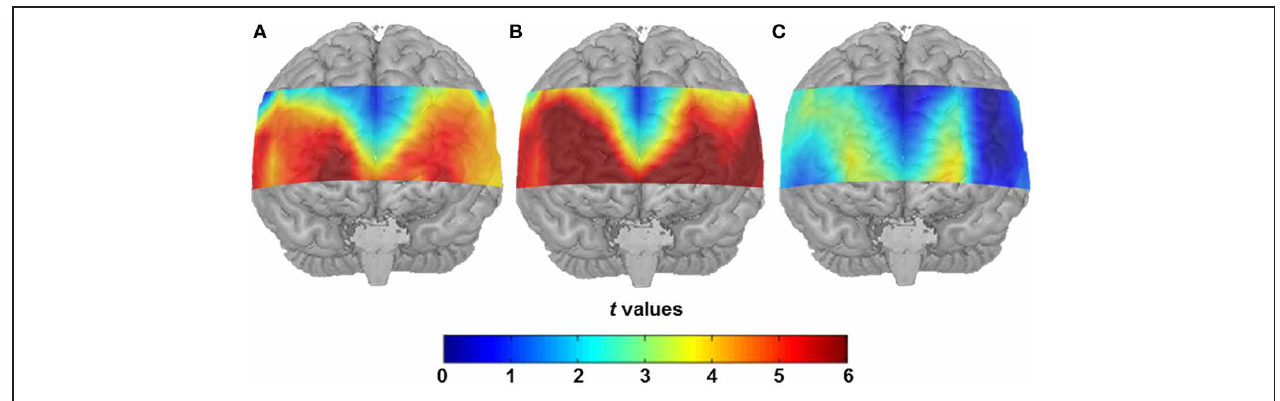
FIGURE 2 | (A) Statistical activation map ( t -values; t -test against 0) for hemodynamic response in the SA condition after correcting for the control condition. (B) Statistical activation map ( t -values; t -test against 0) for